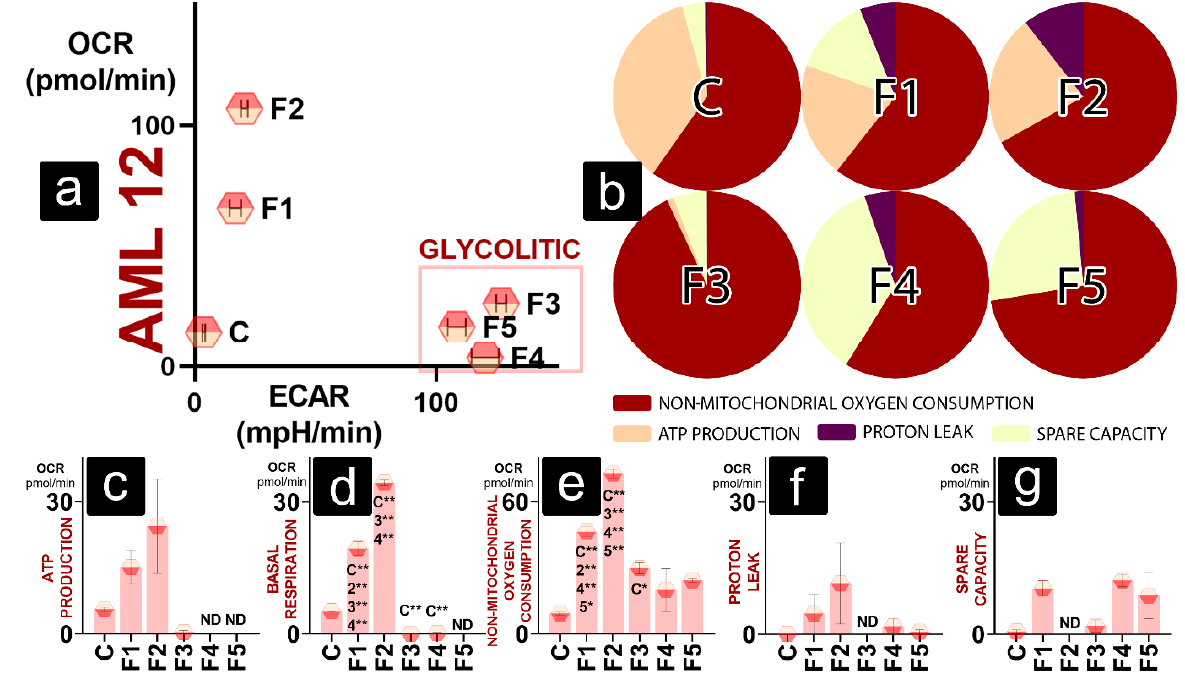
Figure 4. Bioenergetics of AML 12 cells showing ( a ) metabolic profile in normal conditions; ( b ) maximal OCR established as 100% and the oxygen consumption allotted between non-mitochondrial OCR, ATP-linked OCR, proton-leak-linked OCR, and spare-capacity-linked OCR; OCR values for ( c ) ATP production, ( d ) basal respiration, ( e ) non-mitochondrial oxygen consumption, ( f ) proton leak, and ( g ) spare capacity. p < 0.01 (*) or p < 0.05 (**). In contrast to F3, the fraction of NM OCR of F4 is similar to one of the control free cells (C). F5 shows a higher percentage of NM OCR to F4, but, similar to F4, its OCR is mainly allocated for NM OCR and spare capacity (Figure 4b). ATP production is not